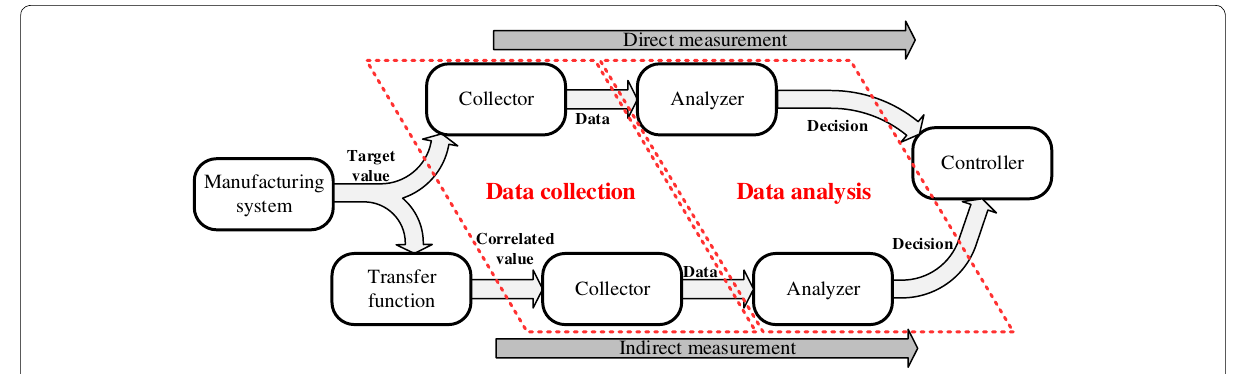
Figure 4 Workflow of direct and indirect